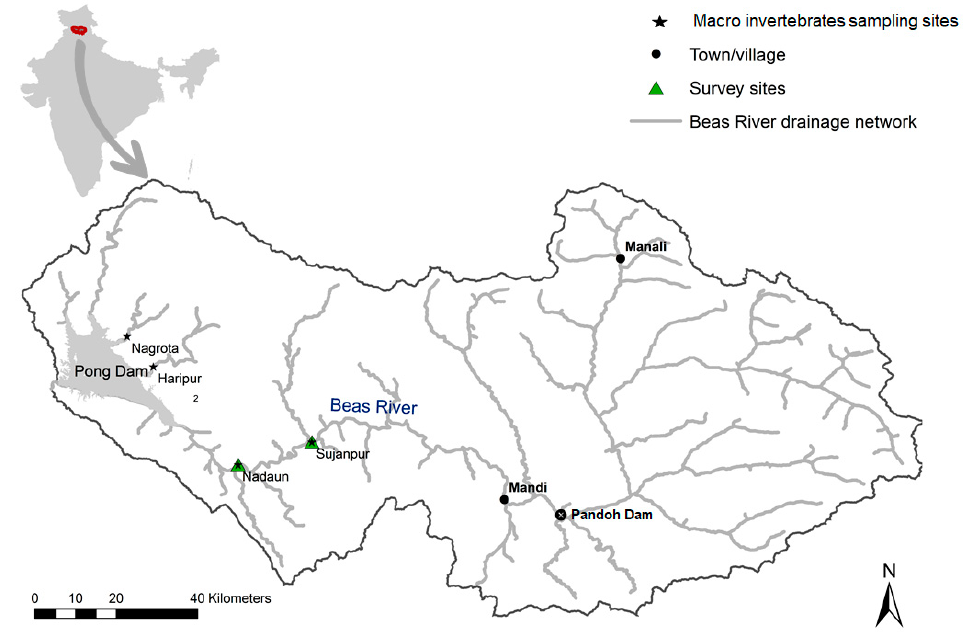
Figure 1. Beas River Basin and its situation (inset top left); the location of the survey sites is indicated.